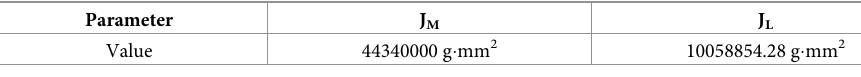
Table 1. Rotational inertia of the SGCMG gimbal servo